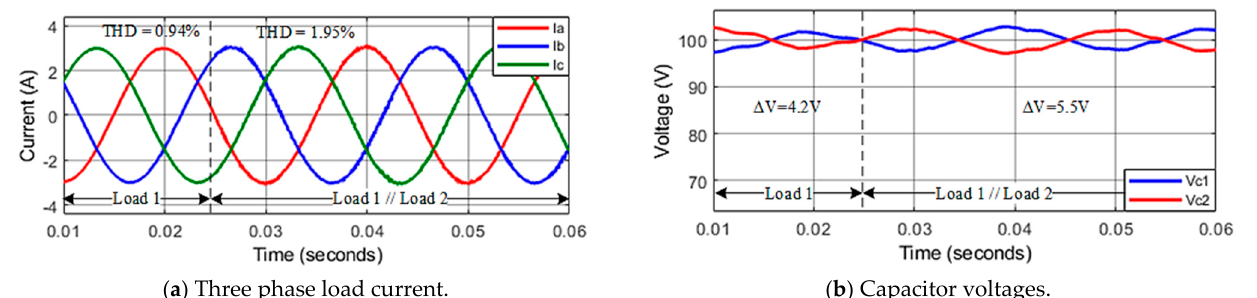
Figure 12. Response of the system in conditions of changing load parameters.